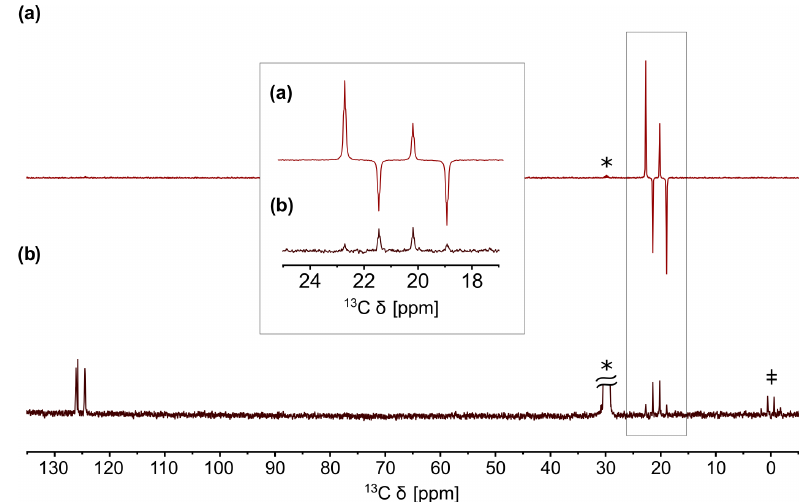
Figure 2. (a) QRIP-enhanced 13 C spectrum of γ -picoline ( 1 ) measured without proton decoupling, recorded with one scan after the cooling and dissolution procedure. Acetone-d6 was used as a solvent. (b) Reference spectrum recorded after full relaxation with 100 scans. The signals of acetone-d6 (labeled with an asterisk; ∗ ) and tetramethylsilane (TMS; ‡) are clearly visible in the reference